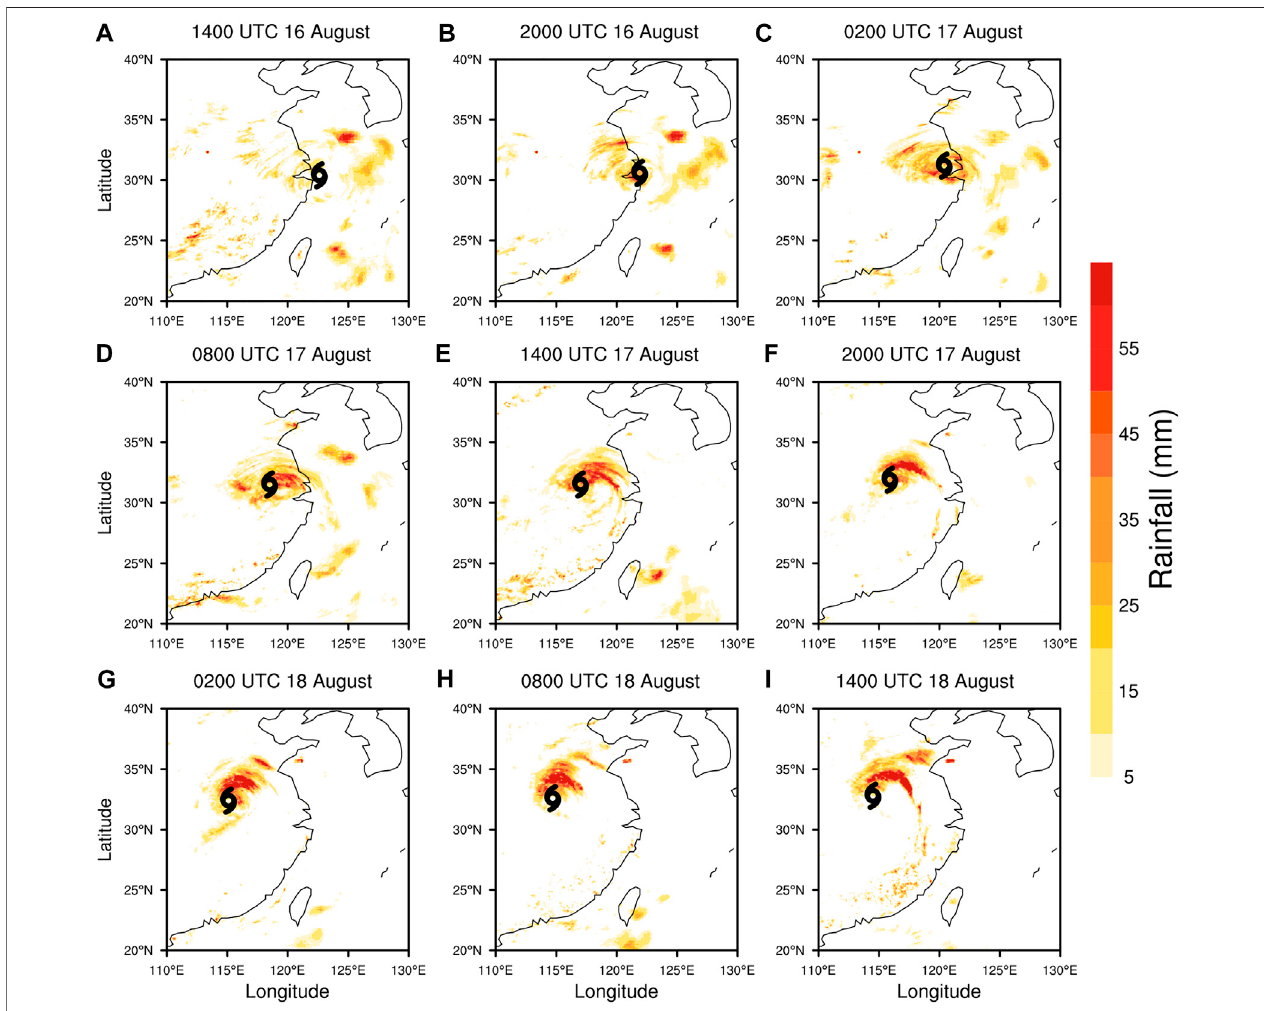
FIGURE 2 | Evolution of the observed 6-hourly rainfall distribution (mm) at (A) 1,400, (B) 2000 UTC 16 August, (C) 0200, (D) 0800, (E) 1,400, (F) 2000 UTC 17 August, (G) 0200, (H) 0800, (I) 1400 UTC August 18, 2018.